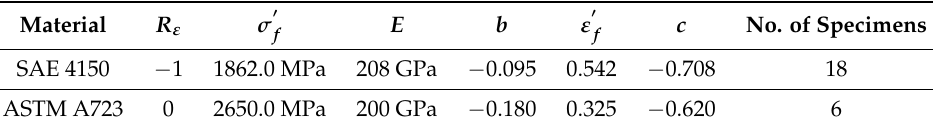
Table 2. Parameters of the Basquin-Manson-Coffin approach of Equation (1) for SAE 4150 at R ε = and ASTM A723 at R ε =